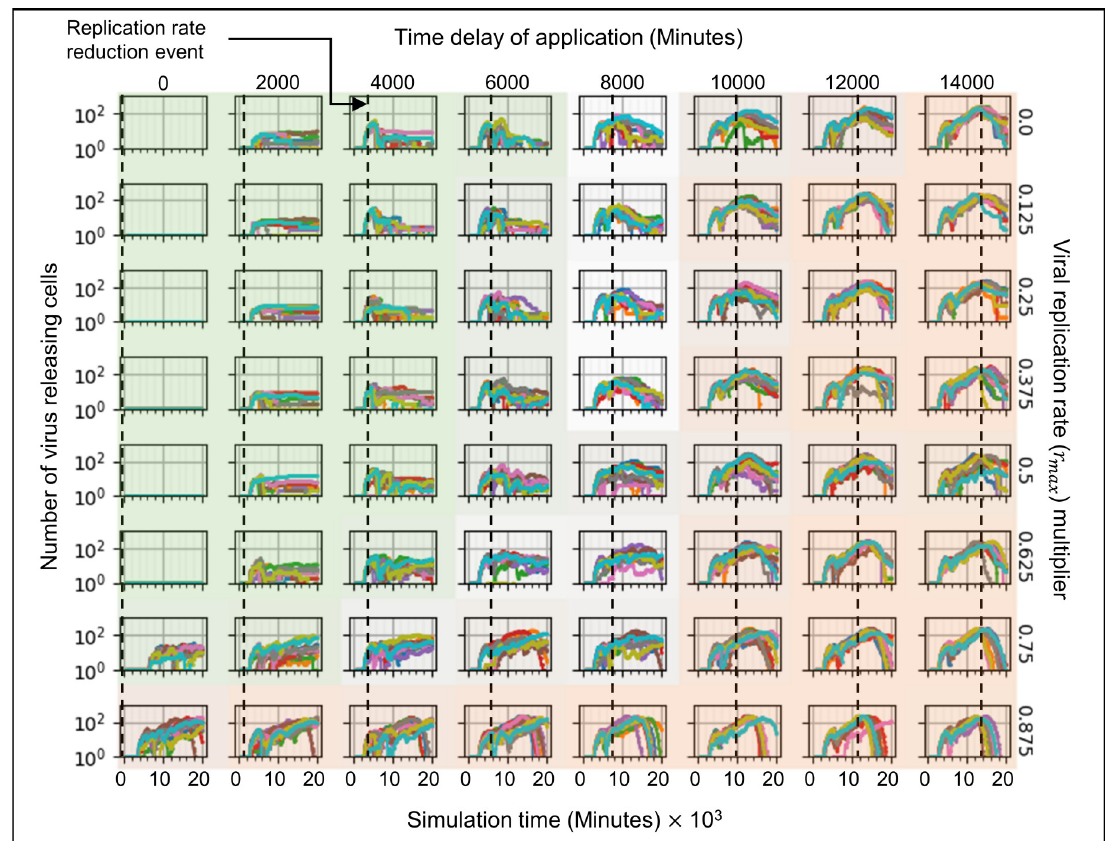
Fig 9. Number of virus releasing cells vs time in simulations of a hypothetical drug treatment reducing the viral genome (e.g. RNA for SARS-CoV-2) replication rate ( r max ) as a function of treatment potency (one minus the viral replication rate multiplier) and time of initiation of treatment. The number of virus-releasing epithelial cells stays low when the intervention occurs early during infection (when the amount of extracellular virus is increasing rapidly), but continues to increase when the intervention occurs later (when the level of extracellular virus is at or near its maximum in the untreated case). Parameter values, axis types and time-scale and shading as in Fig